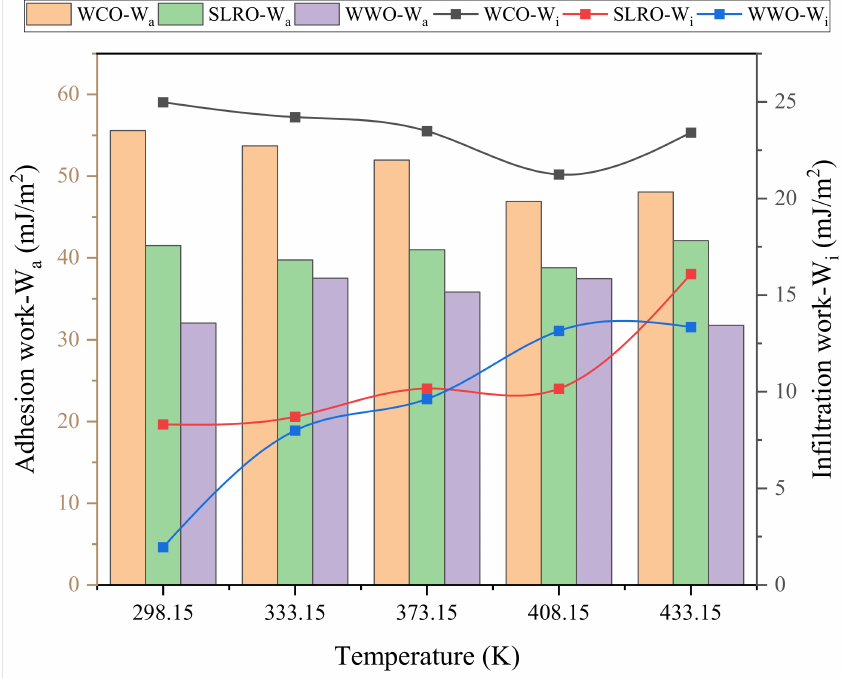
Figure 5. W a and W i of the bio-oils on RTFOT 360 min surface at different